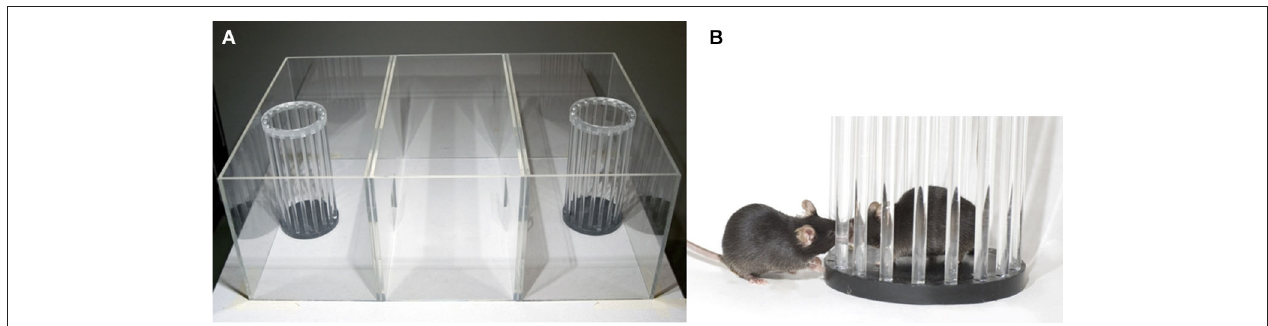
FIGURE 1 | Social approach apparatus. (A) A picture of the apparatus containing the two cylinders; (B) close-up of an interaction between the stranger mouse in the cylinder and the test